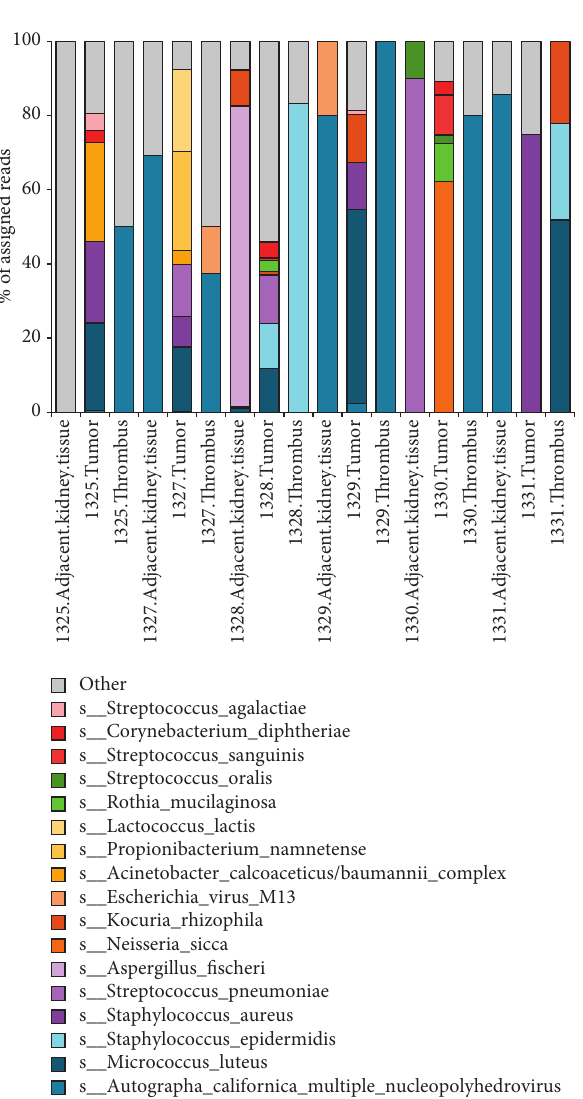
Figure 1: Pathoscope results. Waterfall plot displaying the Pathoscope results identifying the most common microbial genes present in each sample after the removal of PhiX and C. acnes as